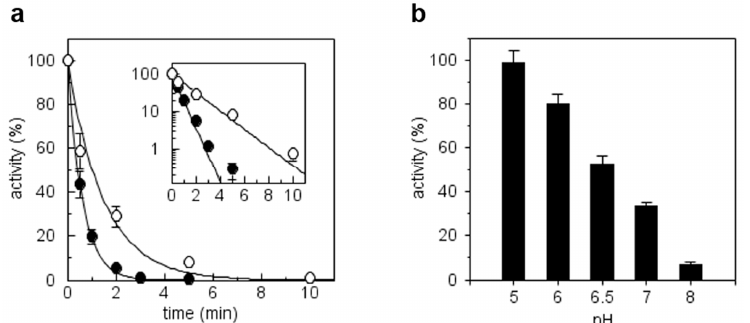
Figure 5. Alkylation treatment of CrTRXh1. ( a ) Reduced enzyme (20 µ M) was incubated with 0.05 or 0.1 mM IAM (open and closed circles, respectively). Aliquots of the incubation mixtures were withdrawn at the indicated time points and the remaining TRX-dependent activity was determined. Data are reported as mean ± standard deviation (SD) ( n = 3). When error bars are not visible, they are within the symbol. ( b ) The reduced enzyme was incubated at the indicated pH values in the presence of 0.1 mM. After 2 min incubation, an aliquot of the sample was withdrawn for the assay of enzyme activity. Data are reported as mean ± SD ( n = 3).